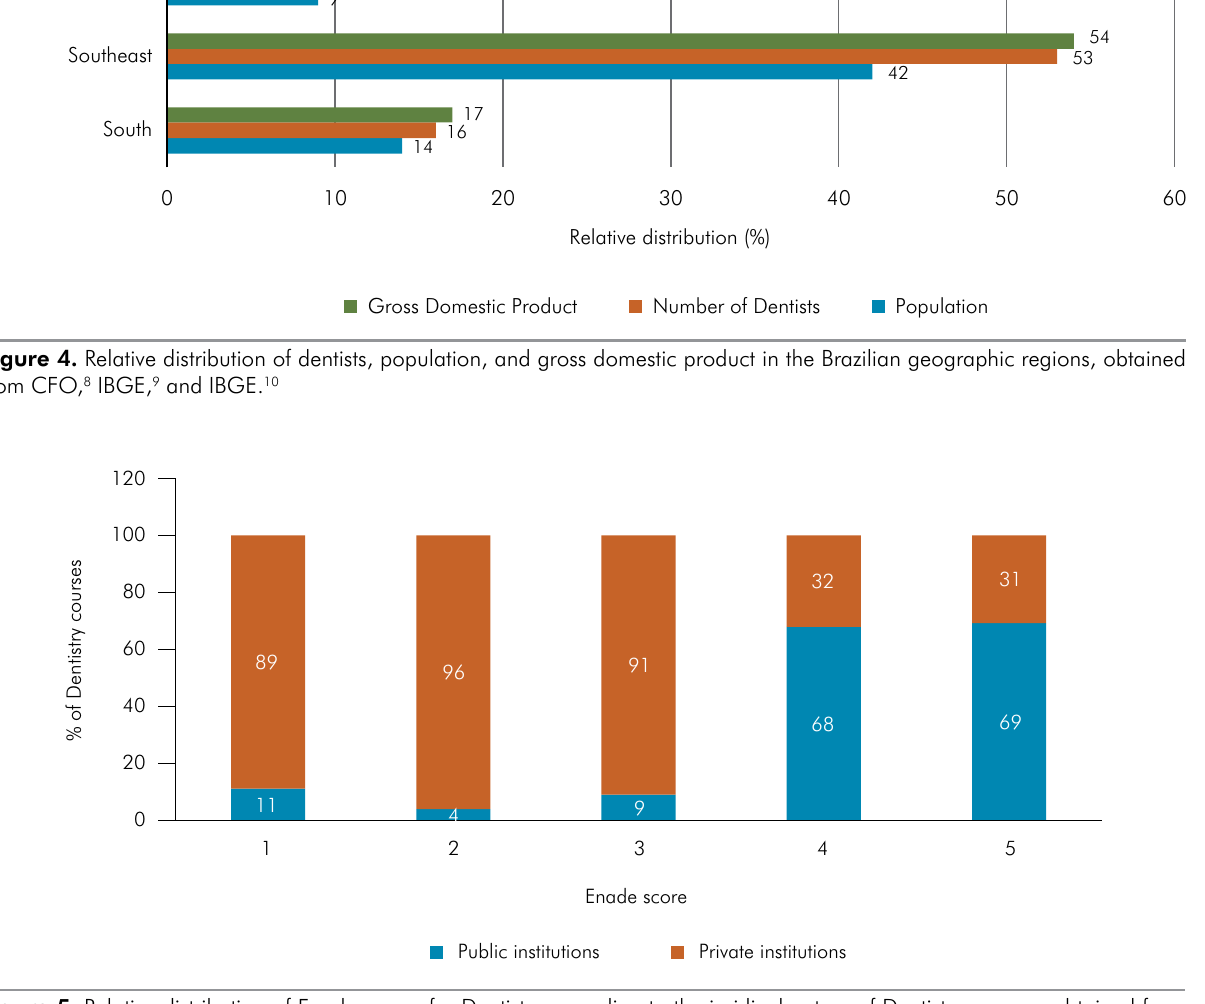
Figure 5. Relative distribution of Enade scores for Dentistry according to the juridical nature of Dentistry courses, obtained from 2016 INEP.